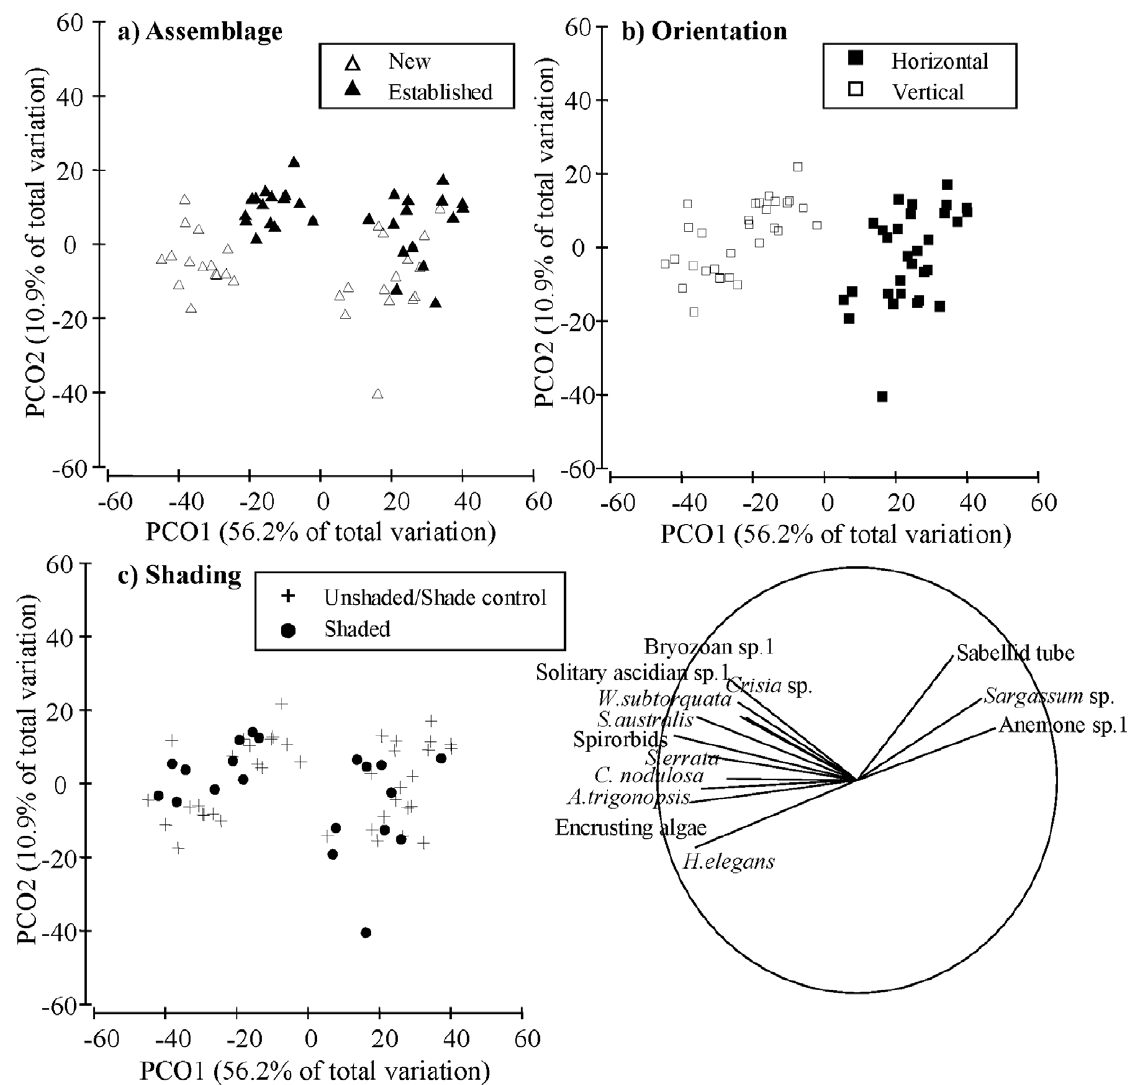
Figure 5. Principal co-ordinates analysis (PCO) comparing the hard-substrate community composition on experimental ‘‘reef’’ (sandstone plates) . Points are are separated by a) resident assemblage (new or established), b) orientation (horizontal or vertical), and c) shading treatment (unshaded/shade control or shaded). The vector overlay indicates which taxa were positively correlated ( . 0.4) with the axes and the length of the vector indicates the strength of the relationship.